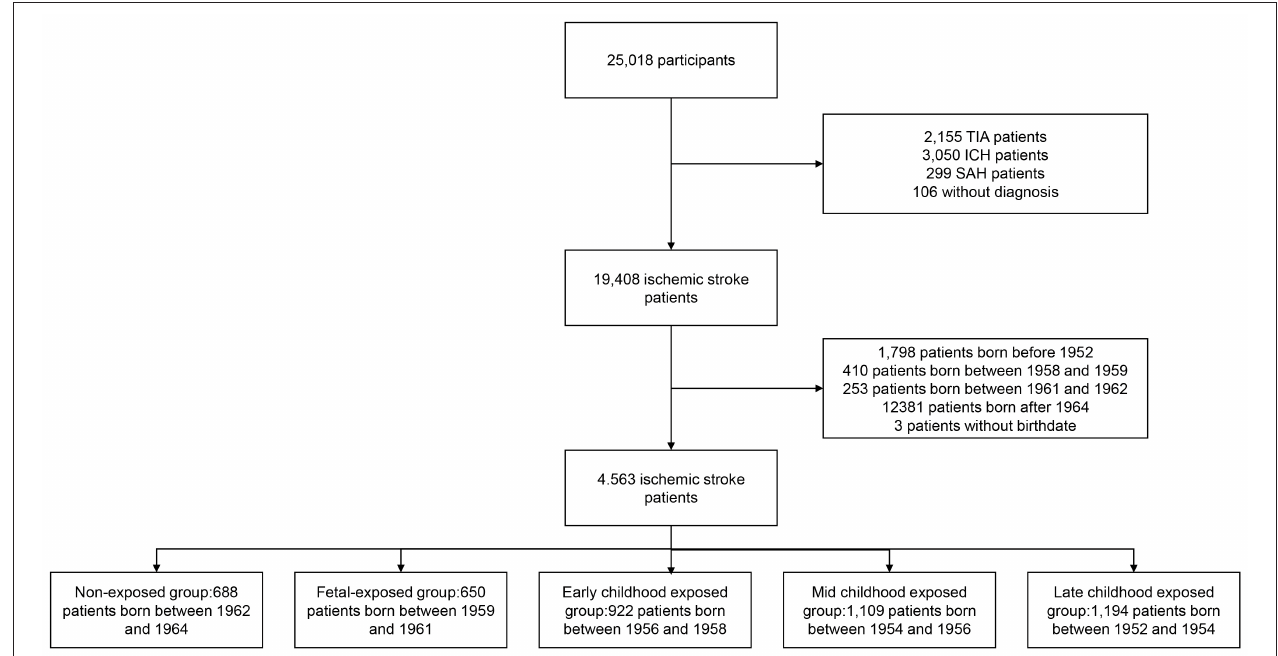
FIGURE 1 | Flow diagram of study participant selection and grouping of included participants. TIA indicates transient ischemic attack. ICH indicates intracerebral hemorrhage. SAH indicates subarachnoid hemorrhage.